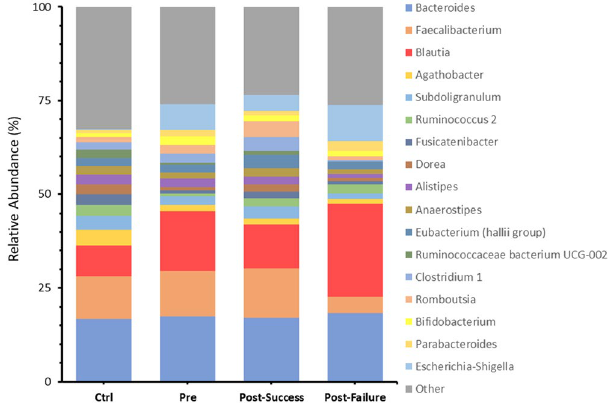
Figure 4. Bar charts showing mean values of ASV abundances at the genus level in the four different groups studied: healthy individuals (control), Crohn’s disease patients pre-treatment (t0) and patients post-treatment (t1; in turn, classified into responders and non-responders). “Other” refers to all genera with an initial representation less than 2% of